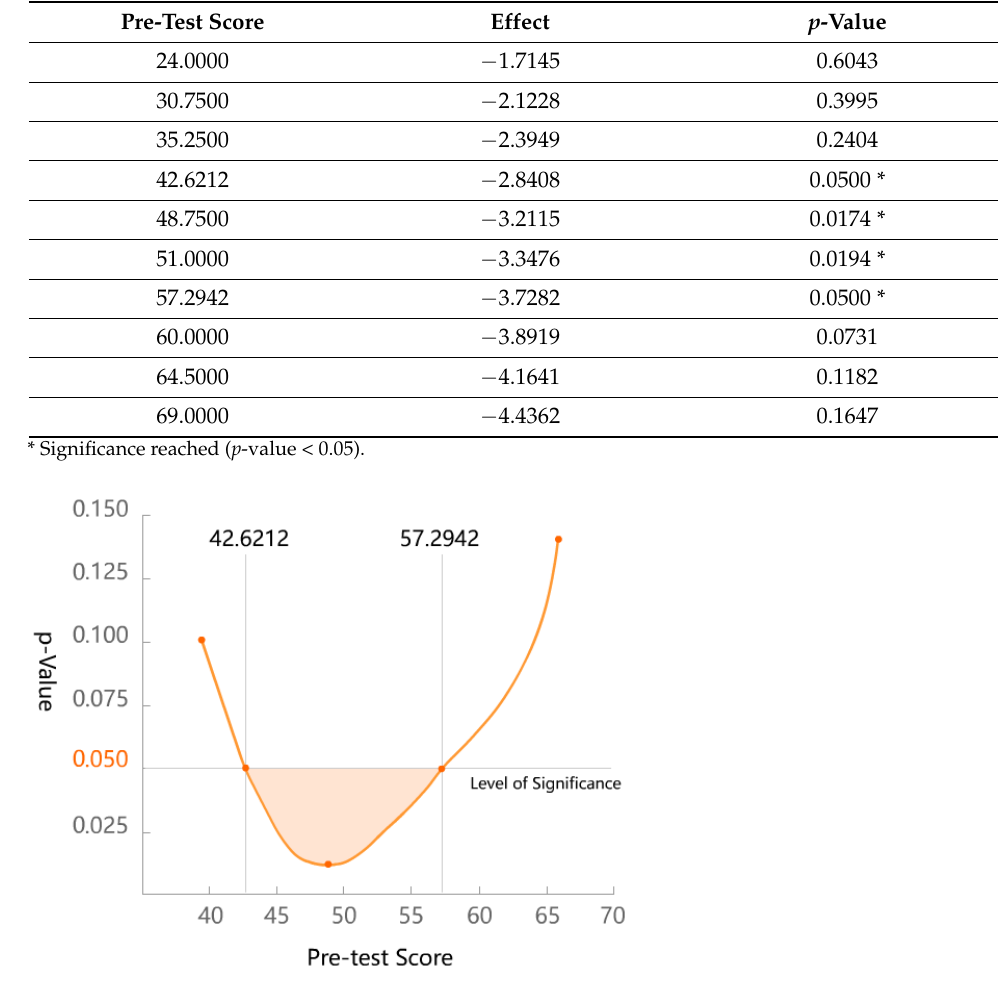
Figure 4. Relationship between the pre-test score and significance.